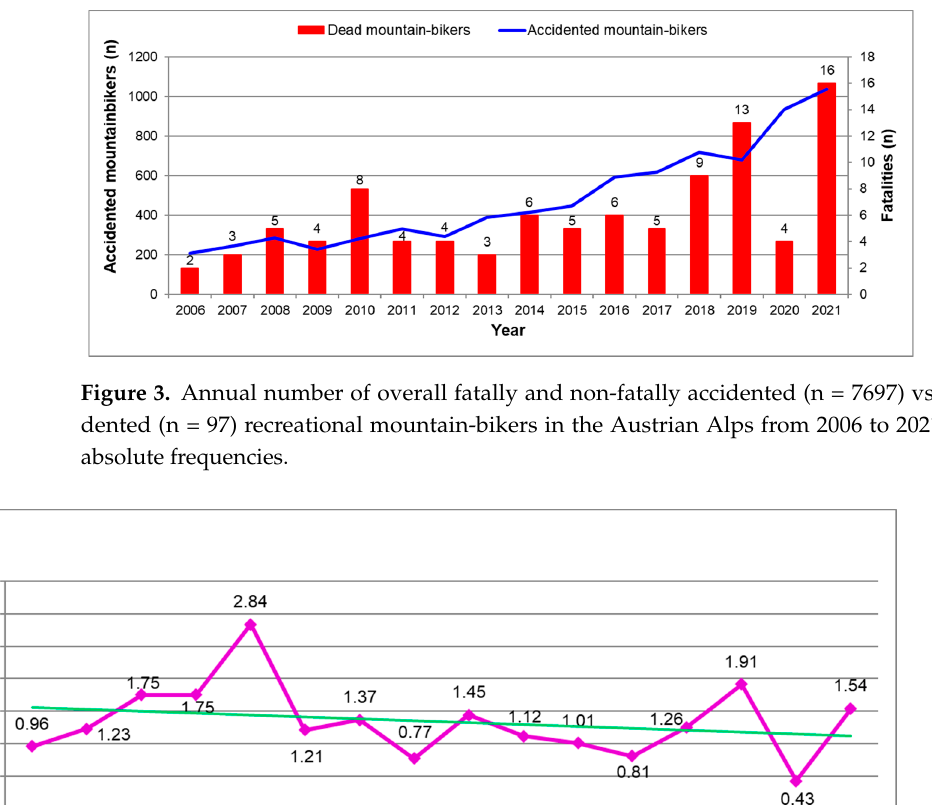
Figure 4. Mortality index (proportion of deaths/accidented victims) during recreational MTB in the Austrian Alps in the period between 2006 and 2021. Green line = trend line.